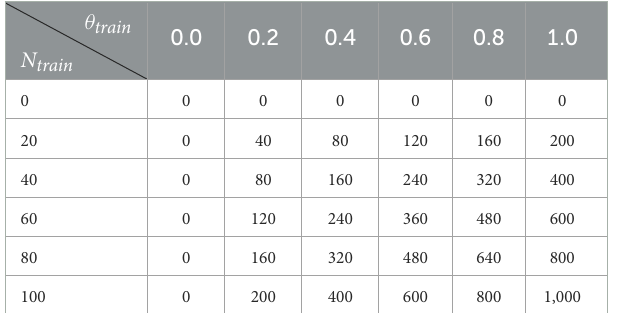
TABLE 7 Cost by level of training support ( θ train ) and number of farmers concerned ( N train ).